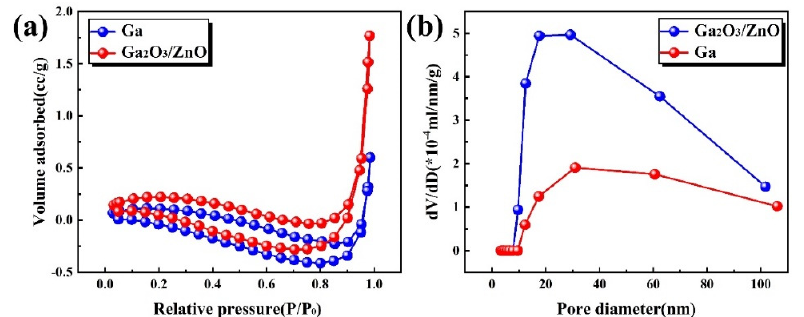
Figure 6. N 2 adsorption–desorption isotherms ( a ) and pore size distribution of Ga 2 O 3 /ZnO ( b ). Table 1. The sample–specific surface area, pore diameter, and pore volume.